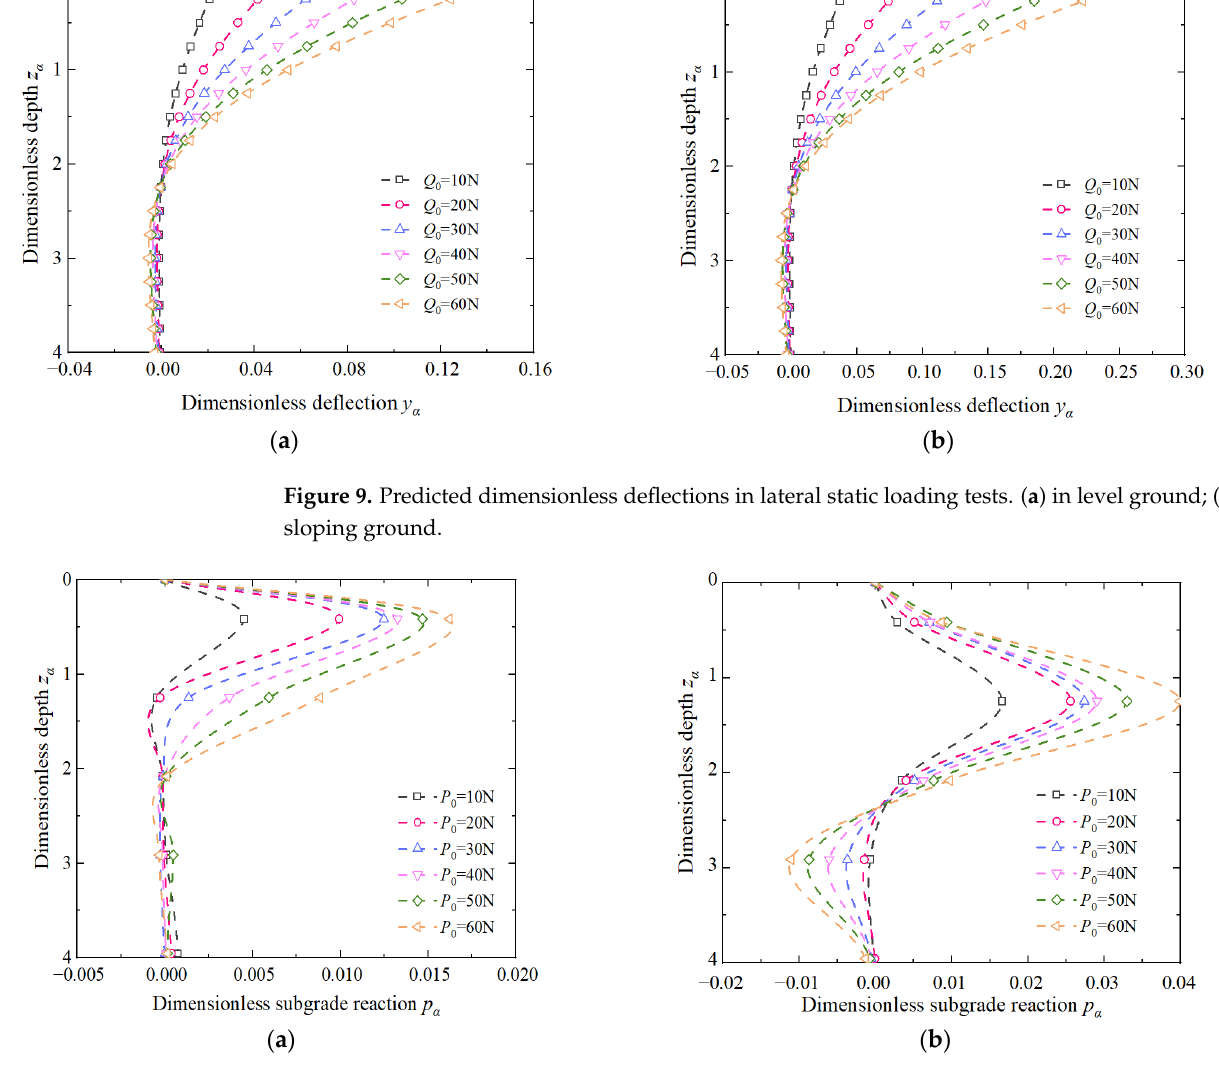
Figure 10. Measured dimensionless subgrade reaction profiles in lateral static loading tests. ( a ) in level ground; ( b ) in sloping ground.